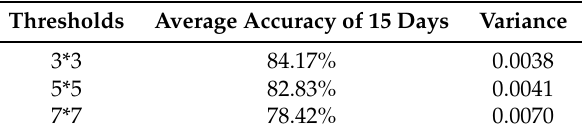
Table 4. Accuracy analysis of different kernel sizes.